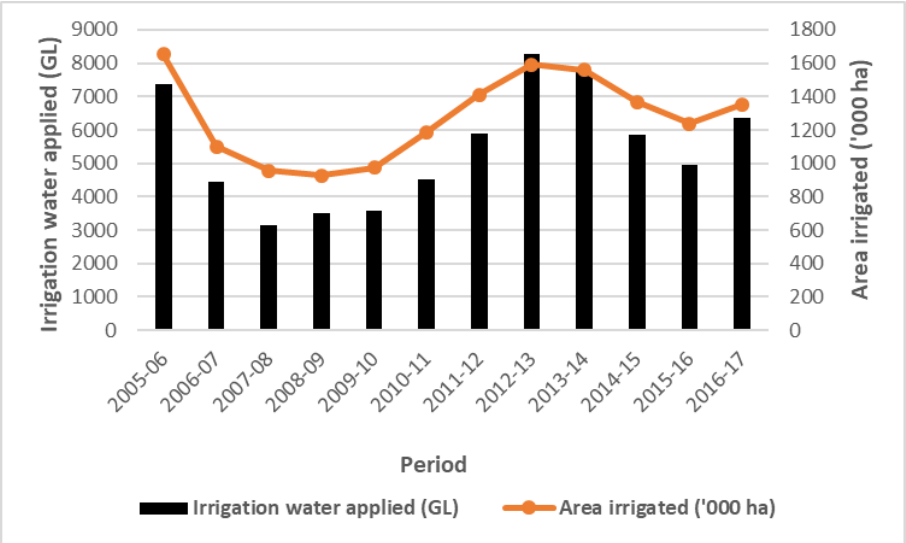
Figure 6. Irrigation water use and area irrigated (‘1000 ha) in the Murray Darling Basin, Australia. (Plotted from data obtained from: ABS 2004–2018.)